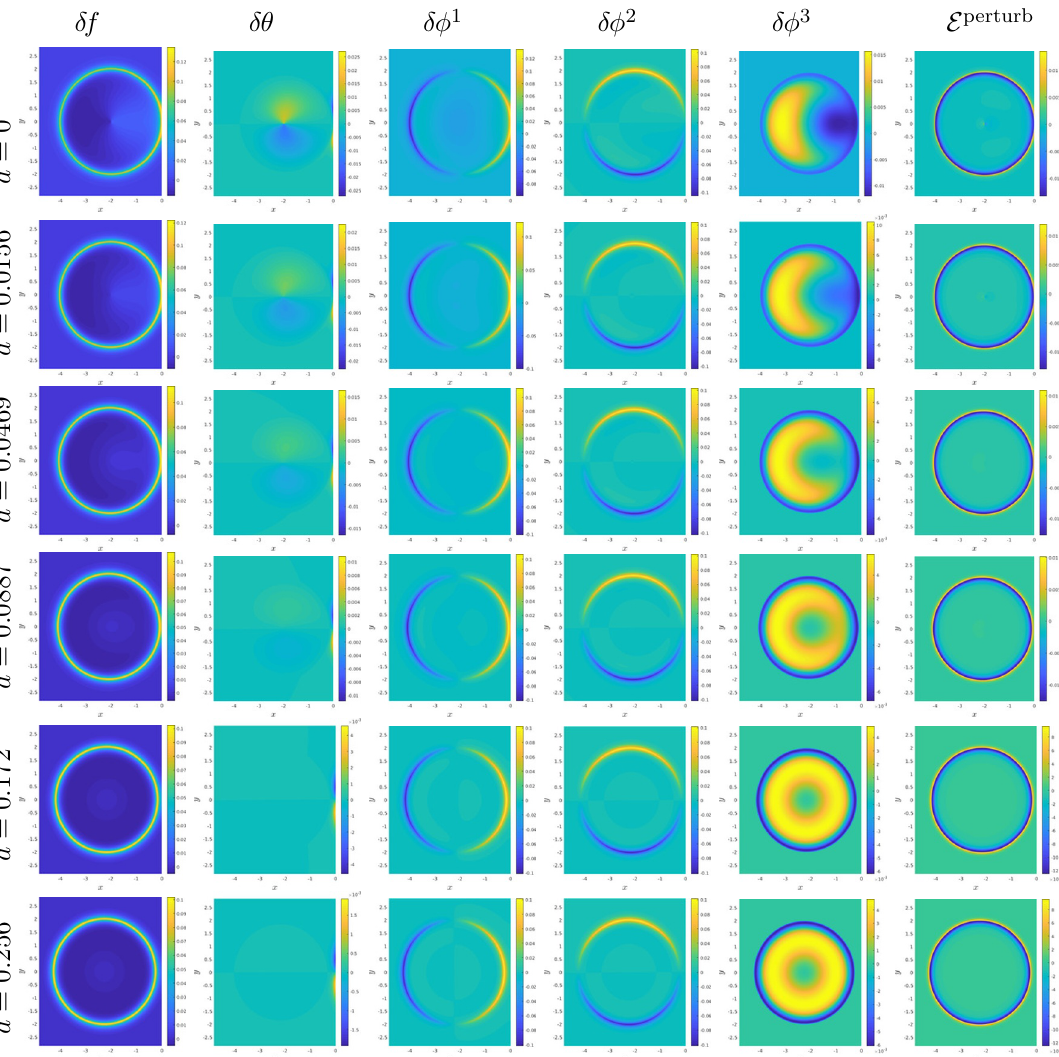
Figure 17 . Numerical solution for δf and δθ for two N = 1 compactons situated next two each other with separation distance 2 a for (cid:15) = 0 . 01 . Due to symmetry of the problem, only the left-hand side is calculated and shown. The gluing conditions (5.9) are imposed at x = 0 , which is located at the right-most part of every panel. Each row displays the perturbations δf , δθ , δφ 1 , δφ 2 , δφ 3 and the energy density of the perturbation E perturb , each in its column. Each panel is cropped so as to render the content as clear as possible; the left, top and bottom border do not represent the size of the